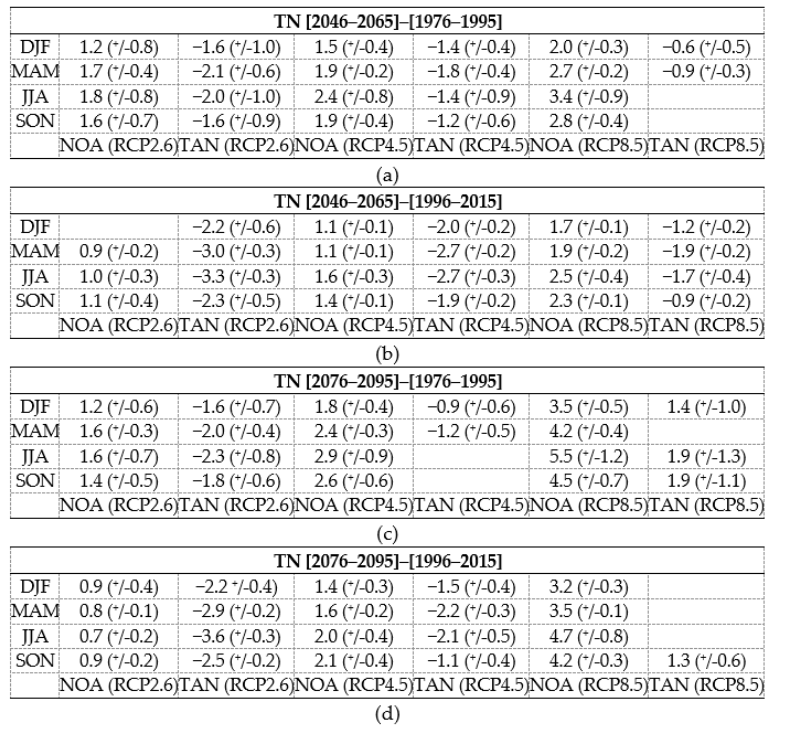
Figure 6. ( a – d ): Statistically significant changes in future seasonal minimum temperatures, compared to the respective reference periods (see Figure 3), at the sites of NOA (urban) and TAN (rural). Values represent the mean change with the respective confidence range. Squares left blank indicate no statistically significant di ff erence. The near and distant future periods (2046–2065 and 2076–2095) are each compared to the first and second reference periods (1976–1995 and